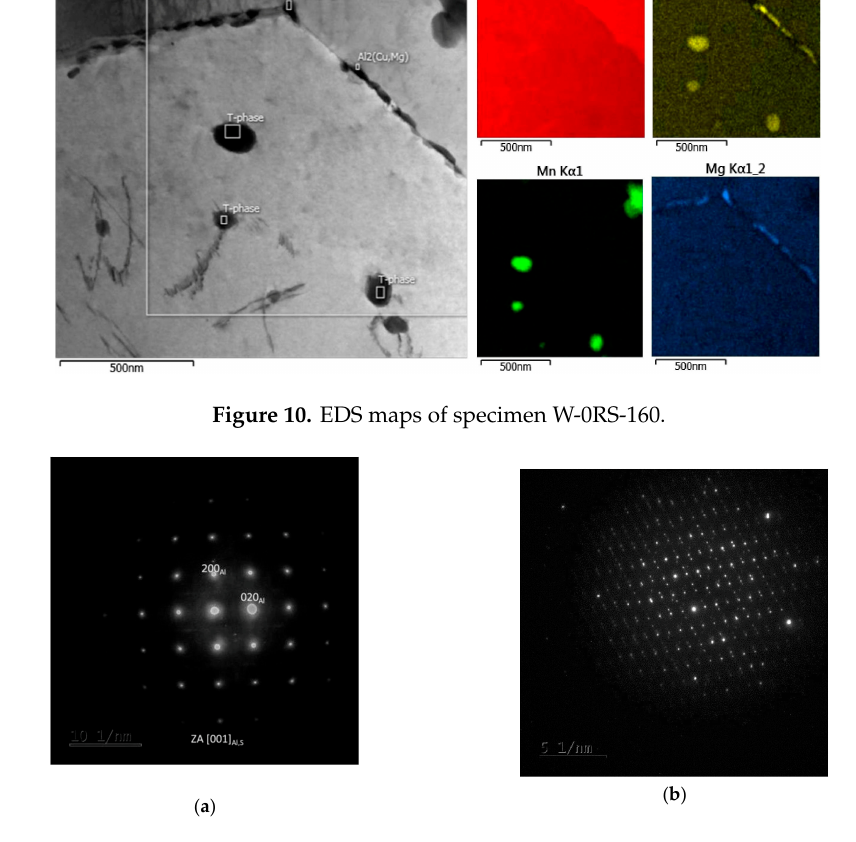
Figure 11. ( a ) Selective electron diffraction pattern: Al matrix in the zone axis [001], the Al matrix is shown as clear spots and a square pattern, whereas the S-phase is represented by dim crosses among the clear spots; ( b ) Diffraction pattern of the T-phase.